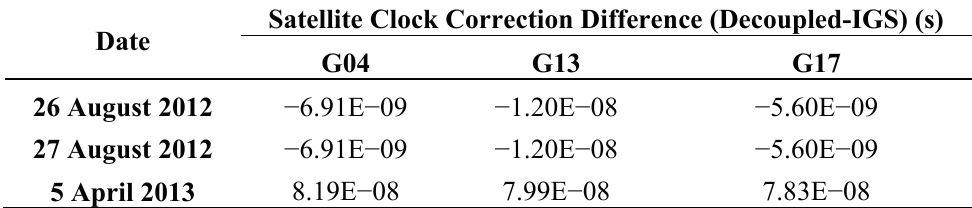
Table 1. Satellite clock correction difference between decoupled and IGS